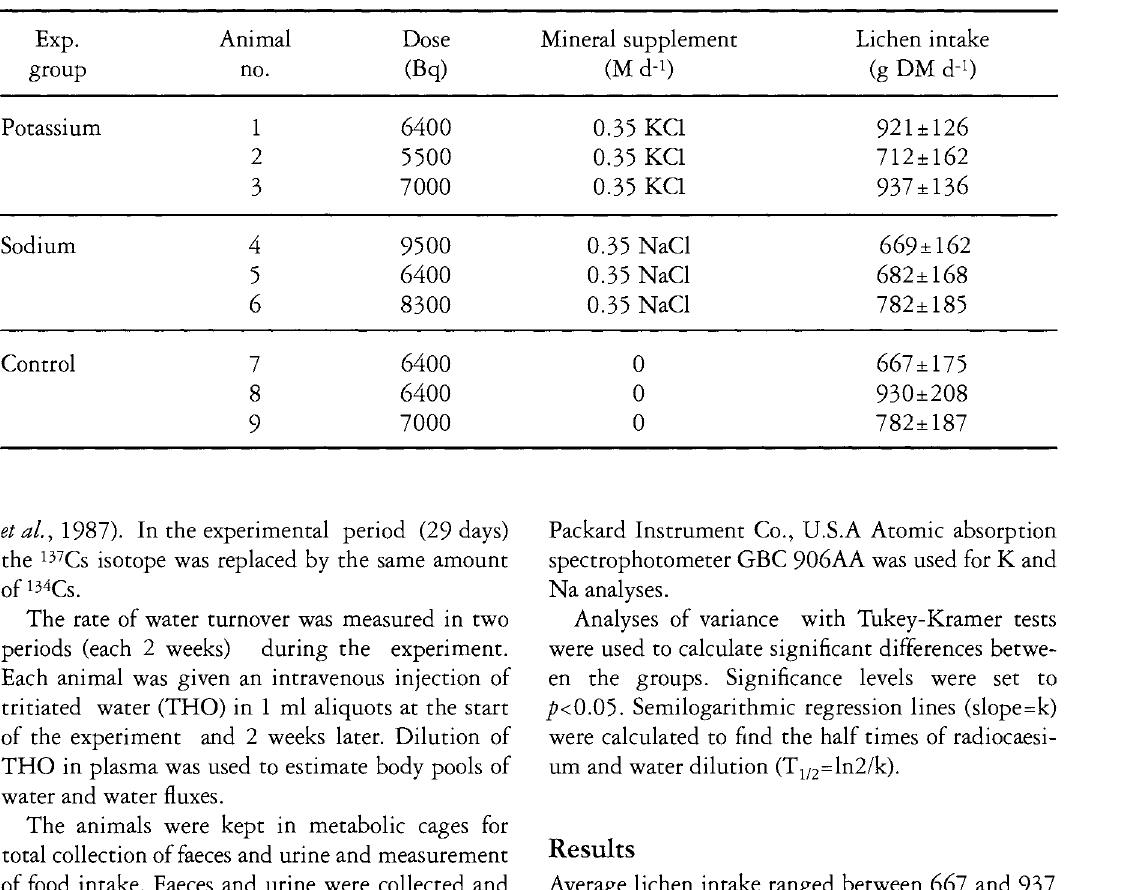
Table 1. Experimental animals daily mineral supplement and intake of radiocaesium and food. Equal doses of 137 Cs were given before the experiment started and 134 Cs during the experiment.